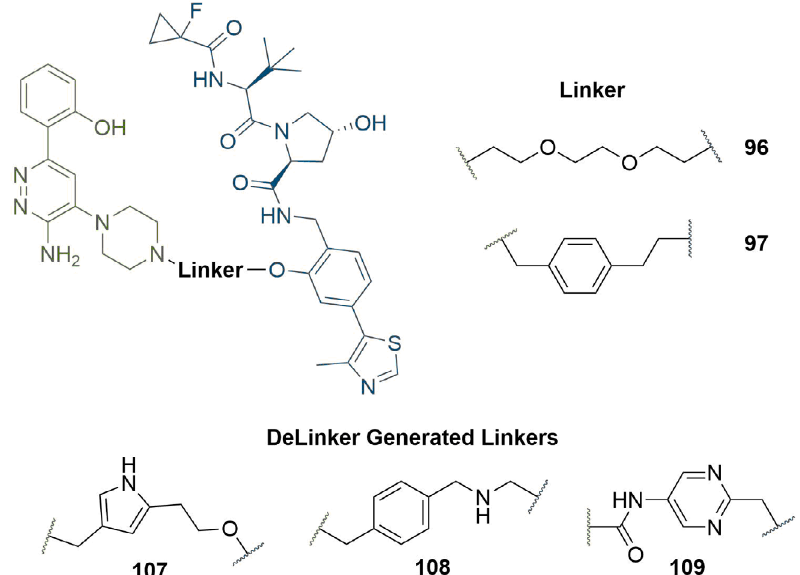
Figure 23. The generative model DeLinker was used to generate novel PROTAC linkers 107-109 to attain the same objective as 97 in improving the interactions of 96 in the